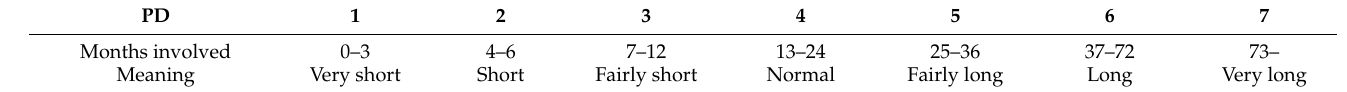
Table 2. Ranking results of